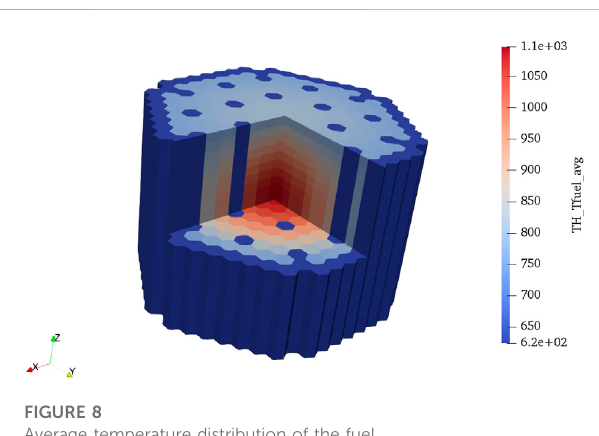
FIGURE 8 Average temperature distribution of the fuel.